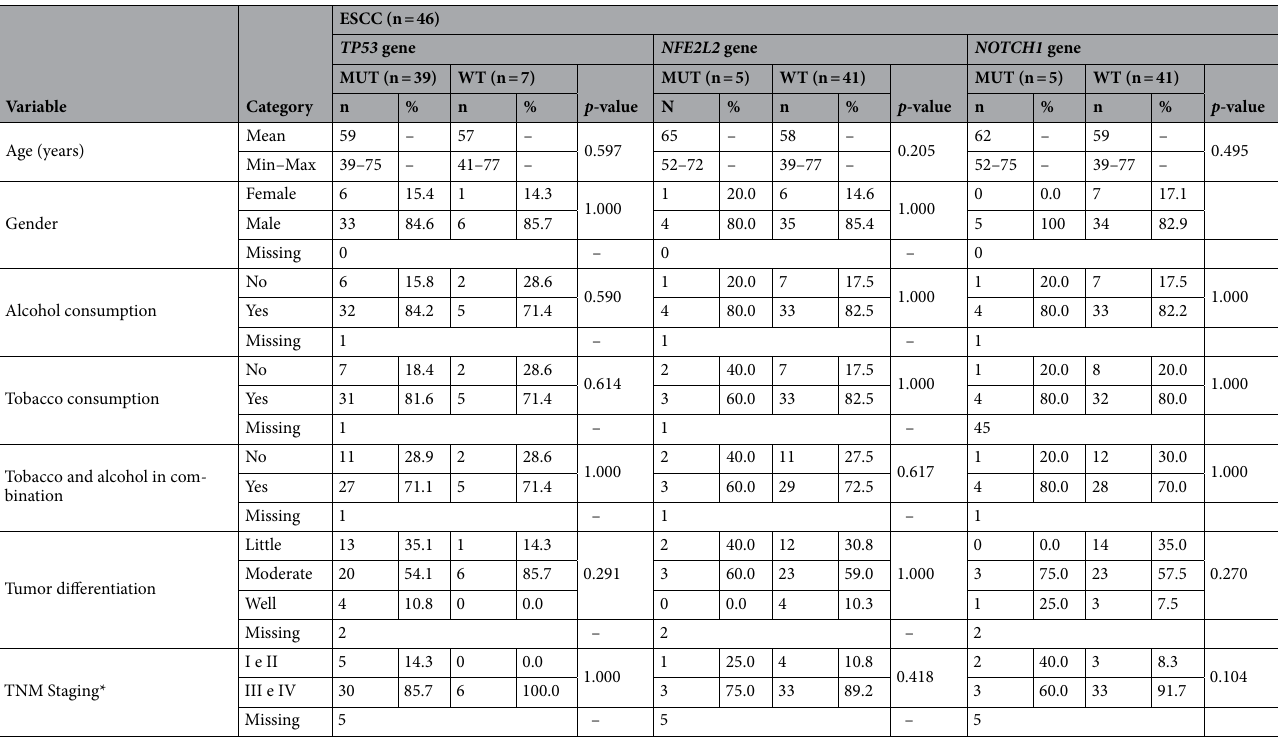
Table 3. Association between patients’ epidemiological and clinicopathological features with the TP53, NFE2L2, and NOTCH1 status. *TNM 7 edition staging. n number of cases. ESCC esophageal squamous cell carcinoma. MUT mutated. WT wild